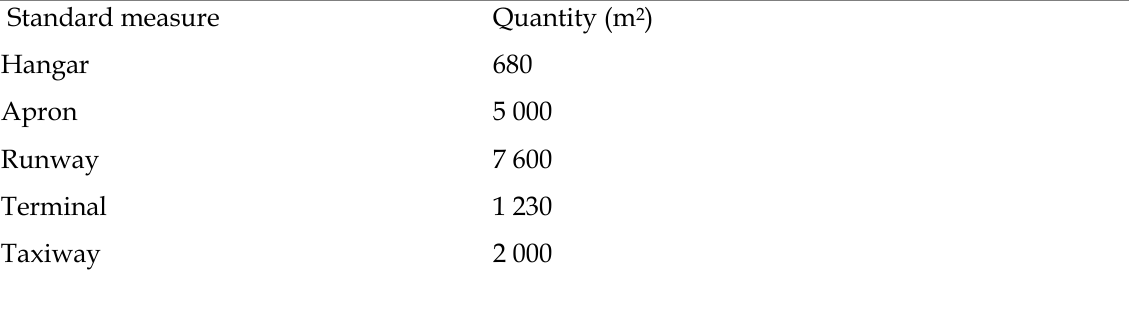
Table A3. New construction at airports during 1 year (arithmetic mean 2010-2015): resulting inventory of standard measures (hangar, apron, runway, terminal, and taxiway).